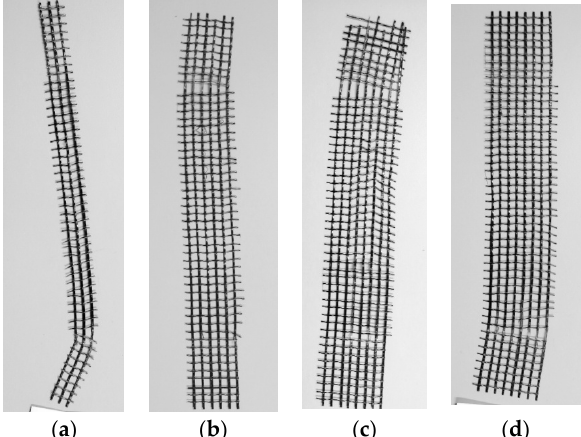
Figure 9. Failure modes of basalt textile strips tested using rough paper in the gripping area: ( a ) 13.5 mm wide specimen, ( b ) 33.5 mm wide specimen and ( c , d ) 47.5 mm wide